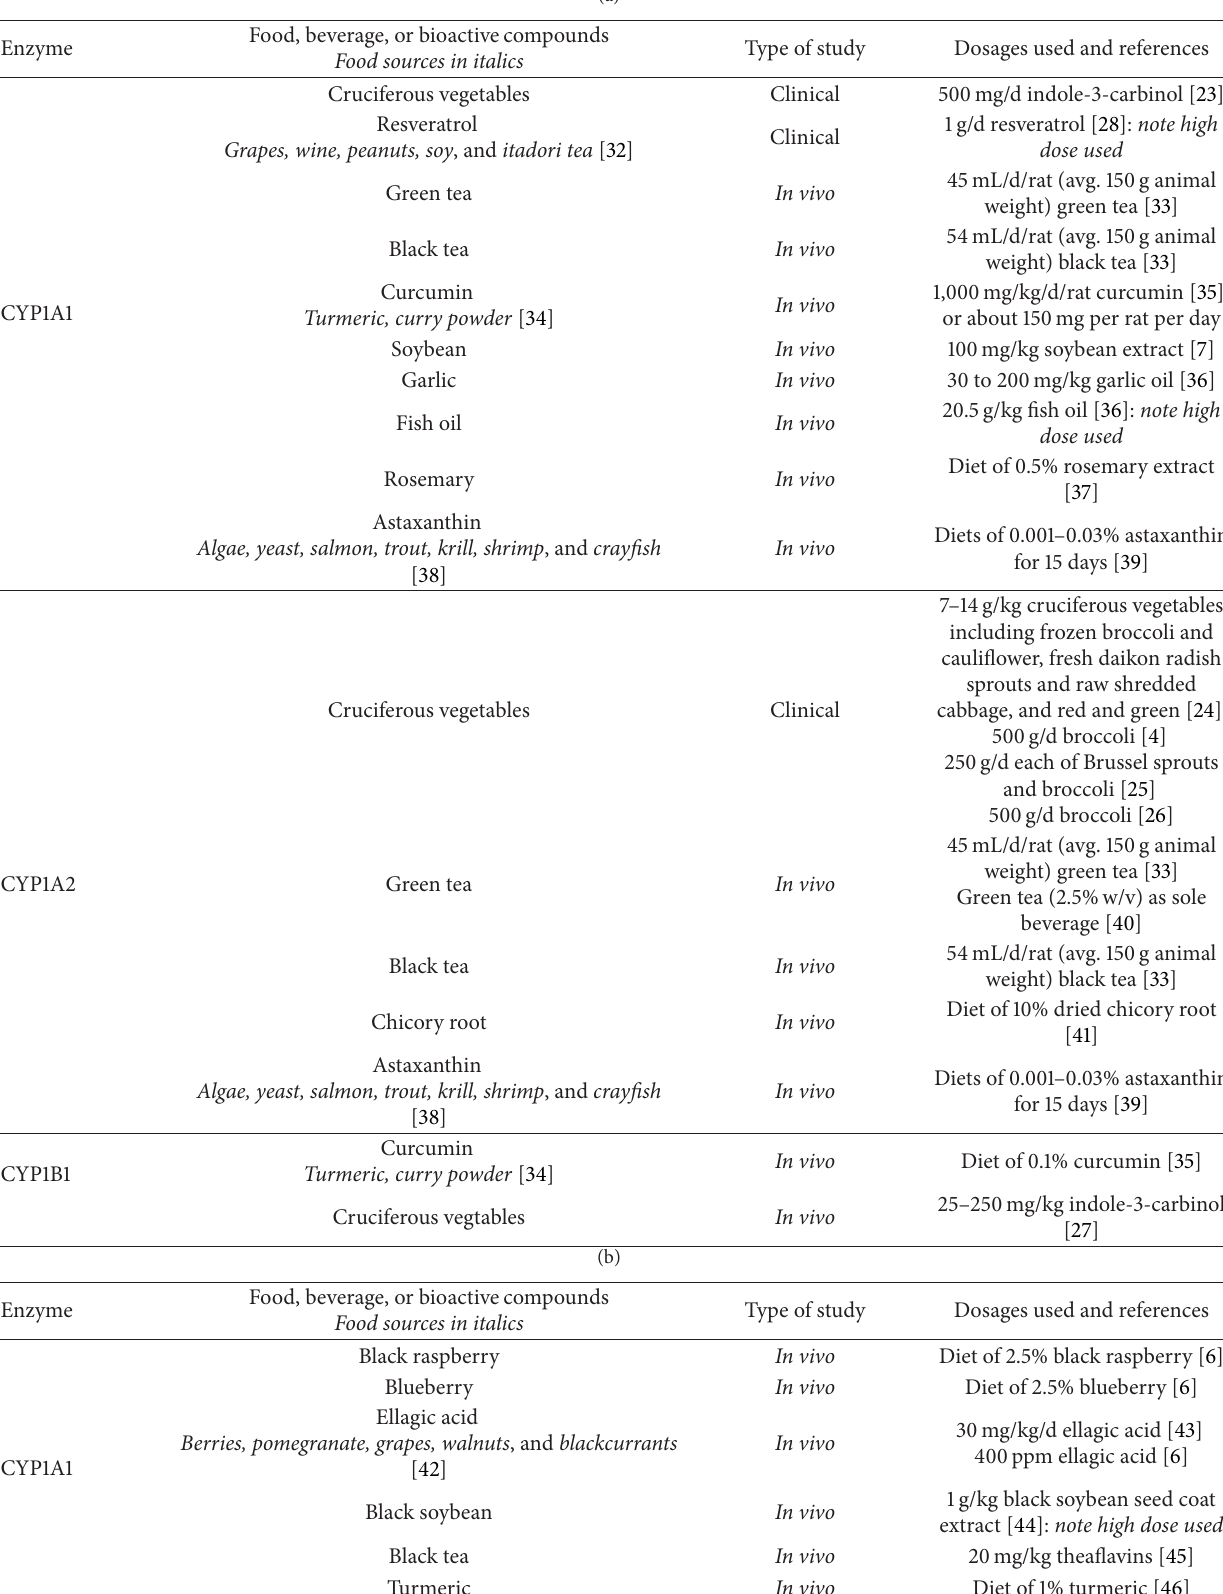
Table 1: (a) Human and in vivo example nutrient inducers of CYP1 enzymes. (b) Human and in vivo example nutrient inhibitors of CYP1